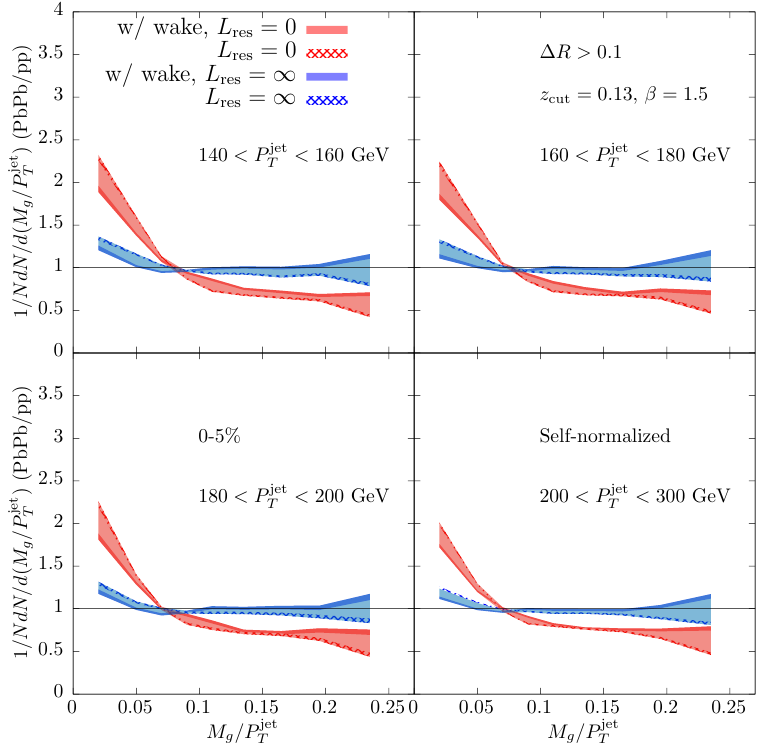
Figure 15 . Ratios of the individually self-normalized distributions of M g =p jet to those in pp collisions, for di(cid:11)erent ranges of the ungroomed jet momentum p jet soft-core grooming procedure, with Soft Drop parameters z cut = 0 : 13 ; (cid:12) = 1 : 5. Red (blue) curves correspond to model calculations with a medium that has L res = 0 ( L res = 1 ). Solid curves correspond to the full results which include particles coming from the wake in the medium; in dashed curves we show results which don’t include